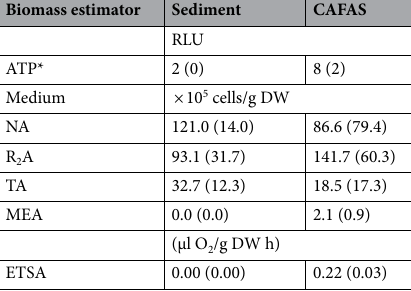
Table 4. Microbial biomass and electron transport system activity (ETSA). Data are mean (standard deviation); *measured in 10 −2